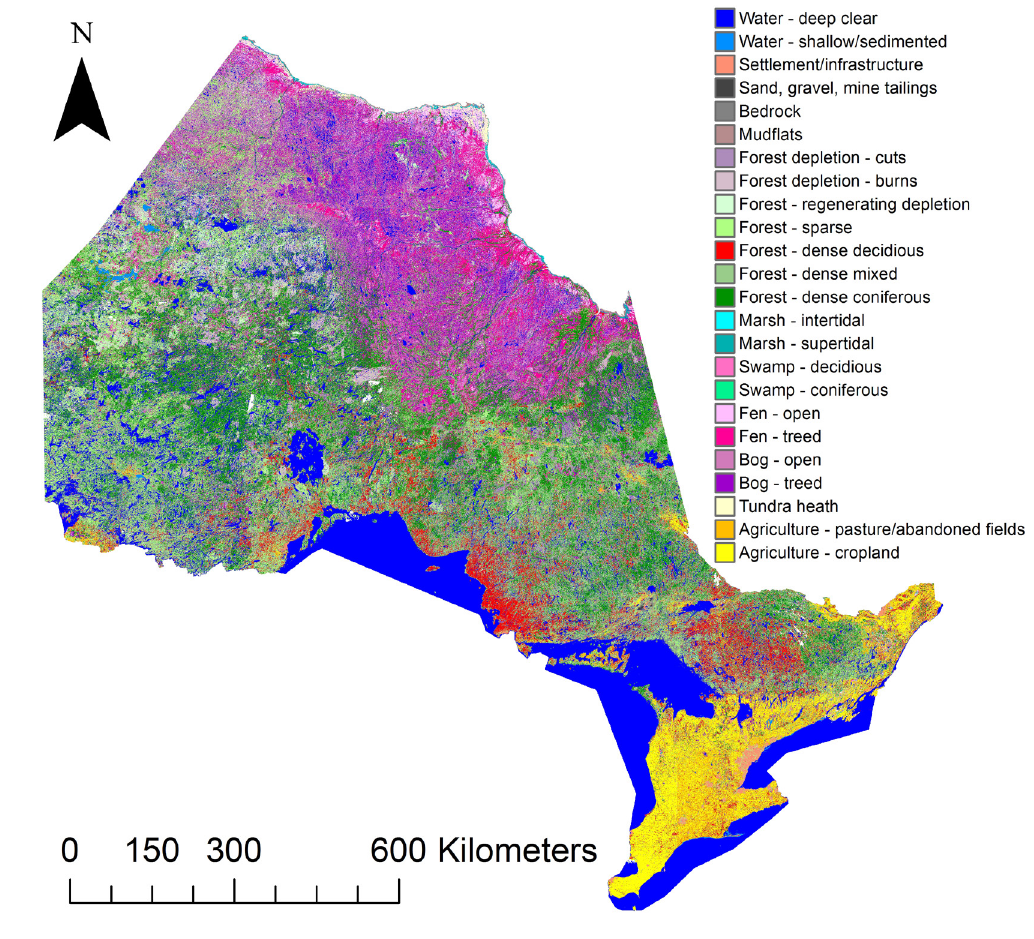
Figure S1. Classification of 24 land types in Ontario in between 1999-2002 by the Ontario Ministry of Natural Resources Landsat-7 Thematic Mapper satellite. Two of the original 26 variables were left out of this figure be- cause their classification was labelled as